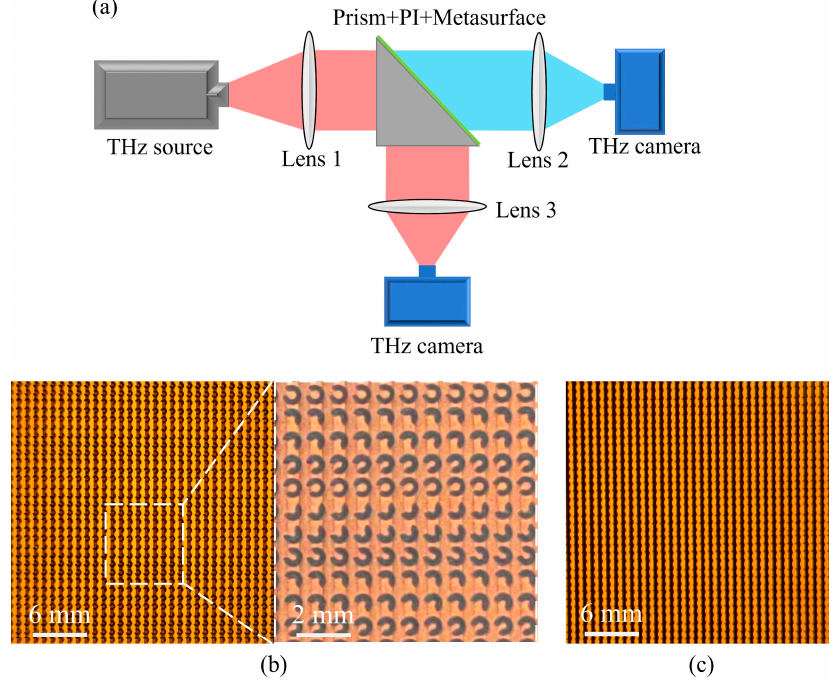
Figure 5. ( a ) Schematic of the experimental setup. ( b ) The black with C-shaped structures (left) and the magnified image (right) of a fabricated metasurface sample. ( c ) Image of the front with a grat-